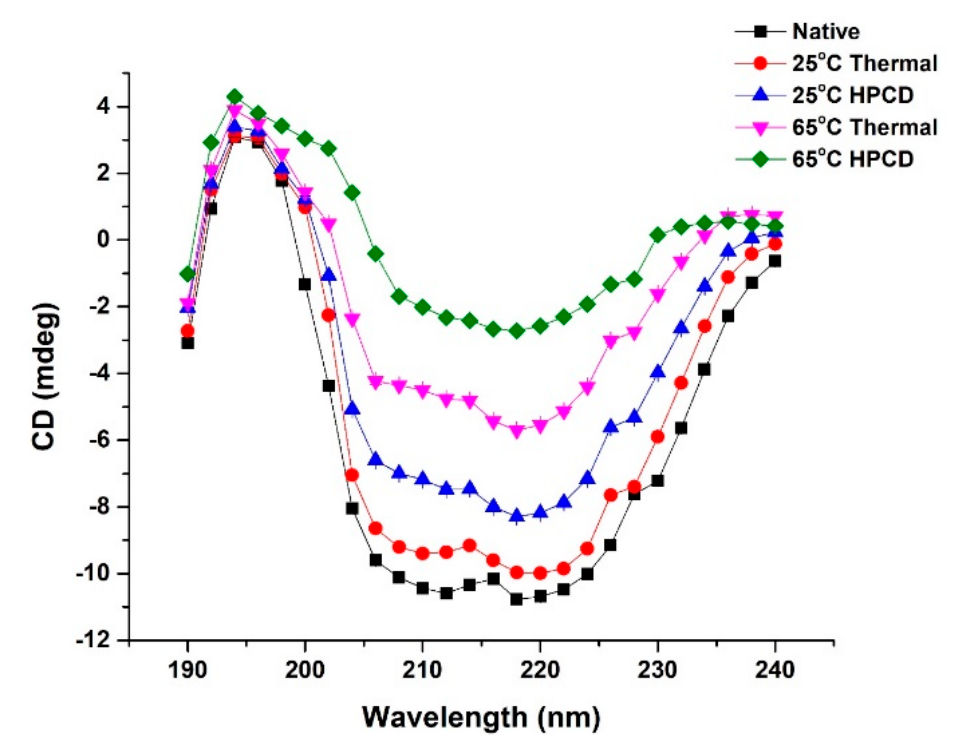
Figure 4. CD spectra of native PPO in comparison to thermal- and HPCD-treated (25 & 65 °C) PPO.